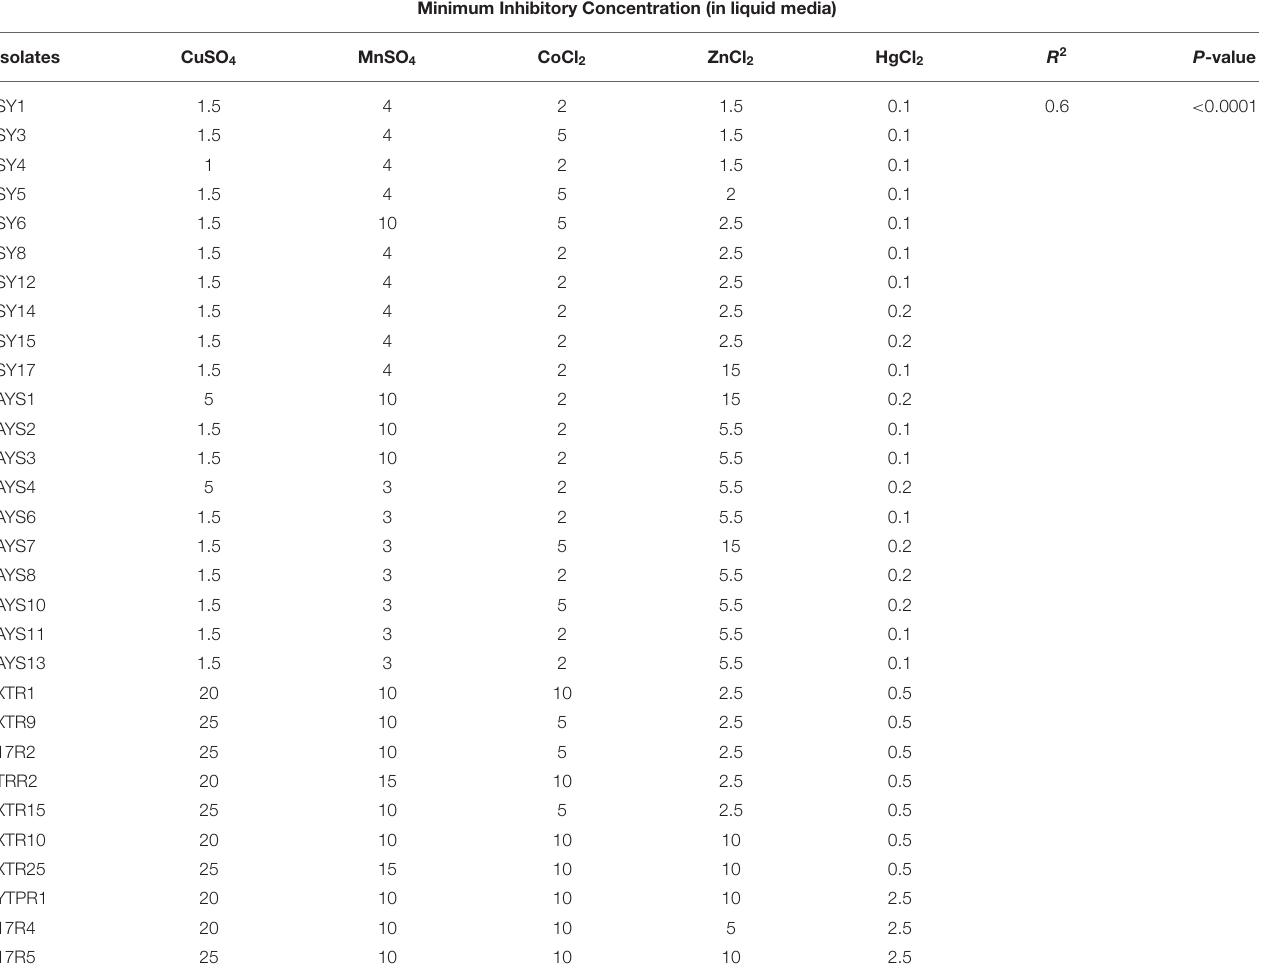
TABLE 3 | Minimum Inhibitory Concentration of heavy metals (in liquid media). Minimum Inhibitory Concentration (in liquid media) Isolates CuSO 4 MnSO